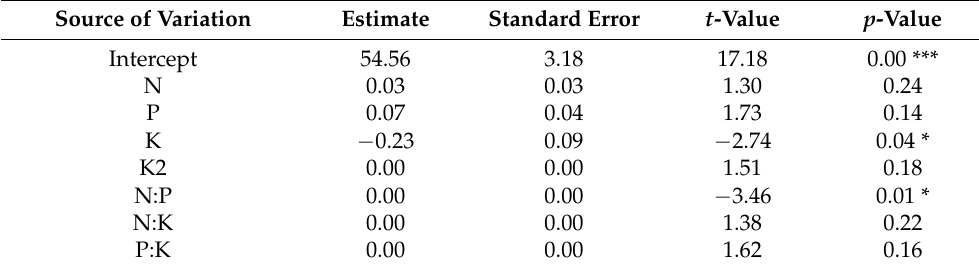
Figure 6. Effects and response surface of interaction among N, P, and K fertilizers on the grain yield ( A – C ) and biomass per plant ( D – F ) of soybean. ( A ) effects and response surface of N fertilizers and P fertilizer on grain yield (fixed factor = 0); ( B ) effects of N fertilizers and K fertilizer on grain yield (fixed factor = 0); ( C ) effects of P fertilizers and K fertilizer on grain yield (fixed factor = 0); ( D ) effects of N fertilizers and P fertilizer on biomass per plant (fixed factor = 0); ( E ) effects of N fertilizers and K fertilizer on biomass per plant (fixed factor = 0); ( F ) effects of P fertilizers and K fertilizer on biomass per plant (fixed factor = 0). Table 5. Analysis of variance of the effects of N, P, and K fertilizers on biomass per